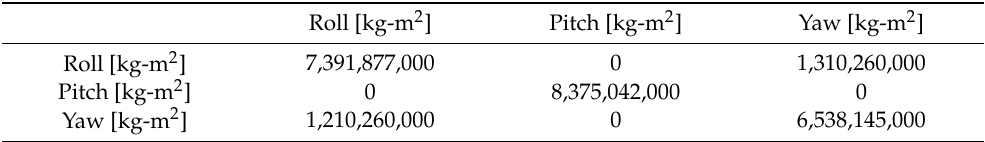
Table 10. 6CP inertia about objective’s center of